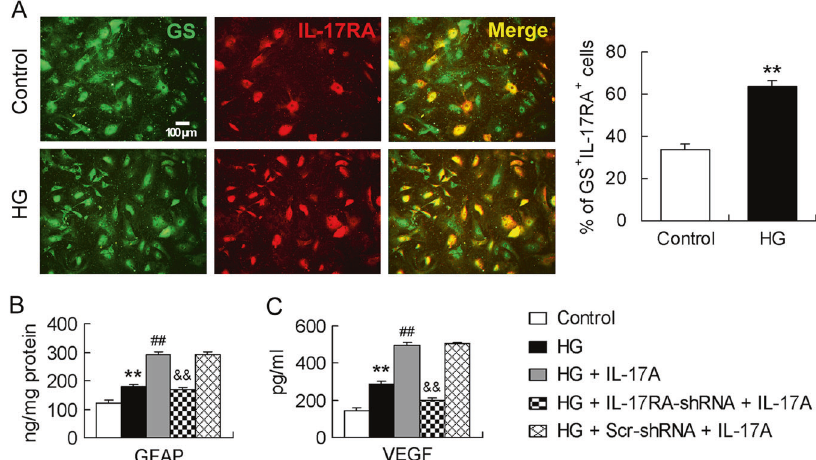
Fig. 4 RMCs express IL-17RA and silencing IL-17RA gene in RMCs abolishes IL-17A deleterious effects. A HG increases IL-17RA expression in RMCs. Primarily cultured RMCs were treated with HG (25 mM) for 48 h and marked with GS. The percentage of GS + IL-17RA + cells in total GS + cells was reported in the statistical histogram and the data were from six independent experiments. B GFAP content in cultured RMC lysates measured by ELISA. The data were representative of fi ve separate experiments. C VEGF concentration in cultured RMC supernatants determined by ELISA. The experiment was repeated eight times. ** P < 0.01, versus control; ## P < 0.01, versus HG; && P < 0.01, versus HG + Scr- shRNA +